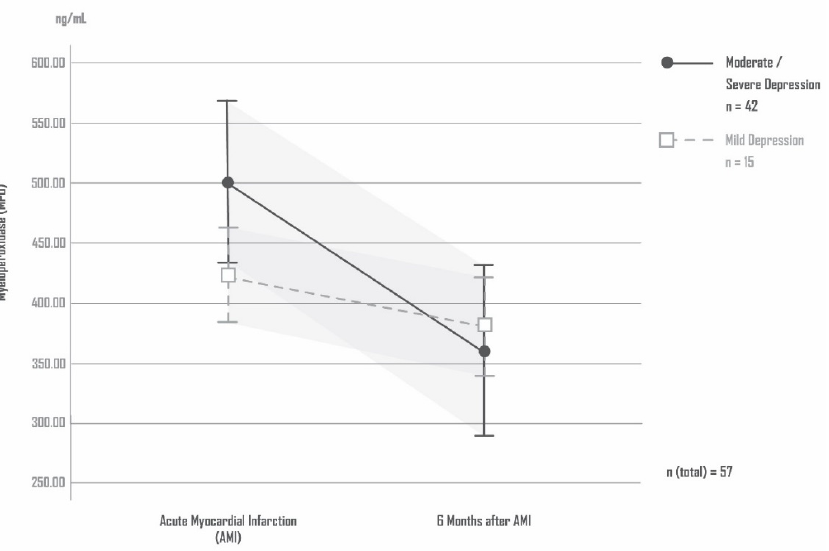
Figure 4 . Levels of MPO in patients with mild and with moderate/severe AMI-induced depres- Figure 4. Levels of MPO in patients with mild and with moderate/severe AMI-induced sion.